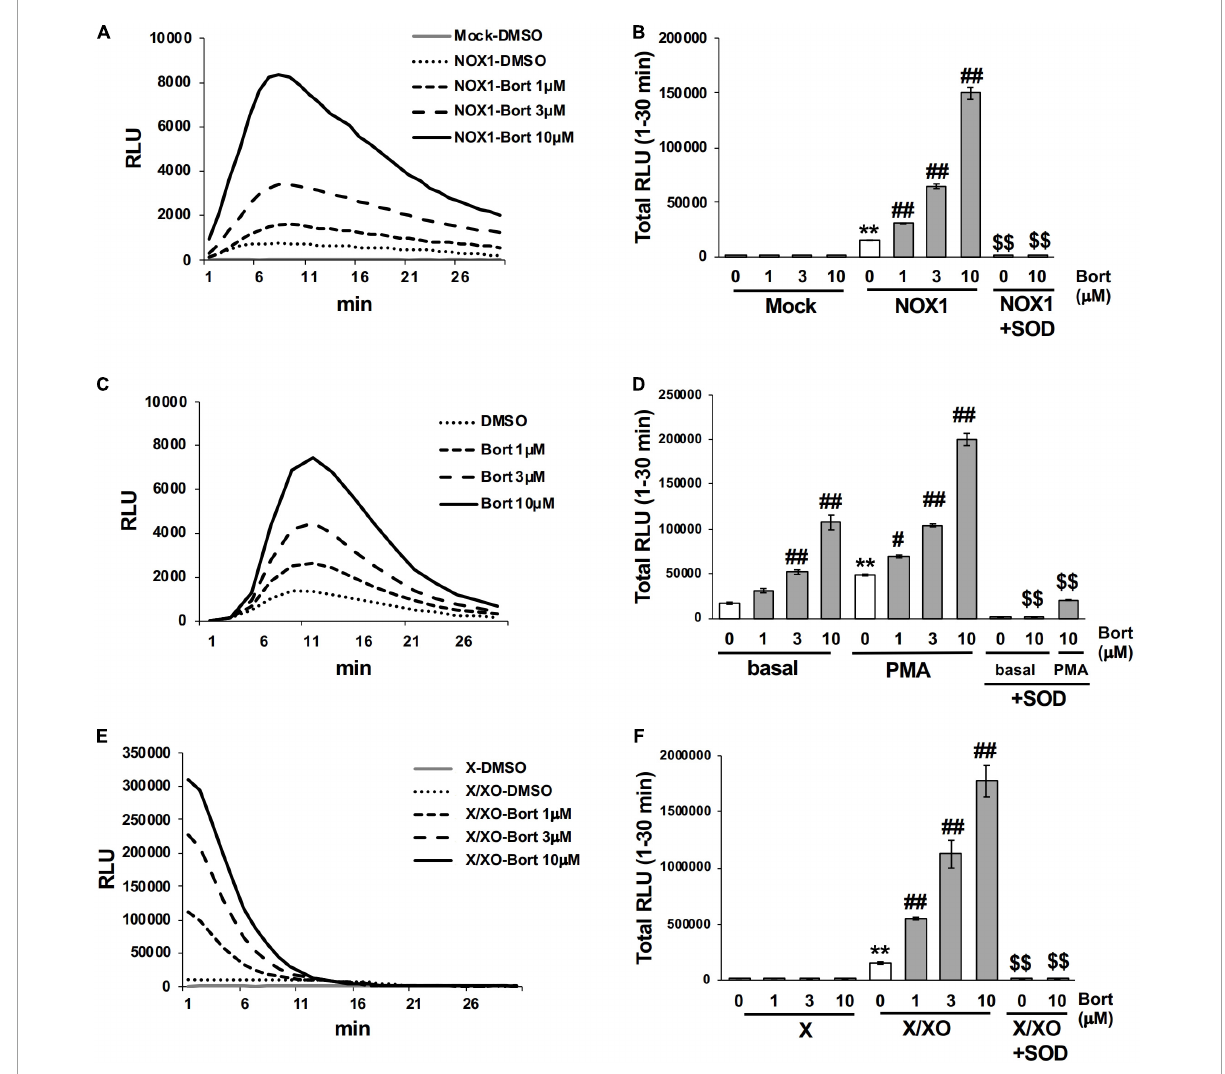
FIGURE2 Bortezomib enhanced the luminescence of L-012 in superoxide production systems. (A) Time course of L-012 luminescence in HEK293 cells overexpressing human NOX1/NADPH oxidase (NOX1, 1 × 10 5 cells/0.1 ml). The chemiluminescence of L-012 was expressed as relative luminescence units (RLU). (B) Total counts of L-012 luminescence during the 30 min measurement. Superoxide dismutase (SOD, 5 U/ml) was pre-incubated with bortezomib/DMSO for 10 min before measurements. Time course (C) and total counts (D) of L-012 luminescence